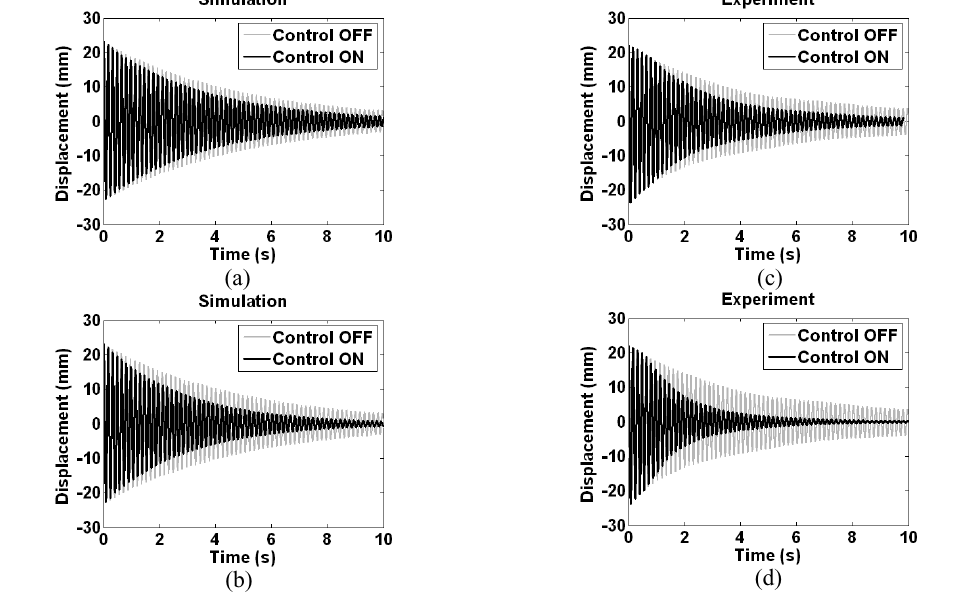
Fig. 10. Case 1 vibration responses for displacement feedback control, simulation for (a) K p = 1 and (b) K p = 2, experiment for (c) K p = 1and (d) K p = 2.